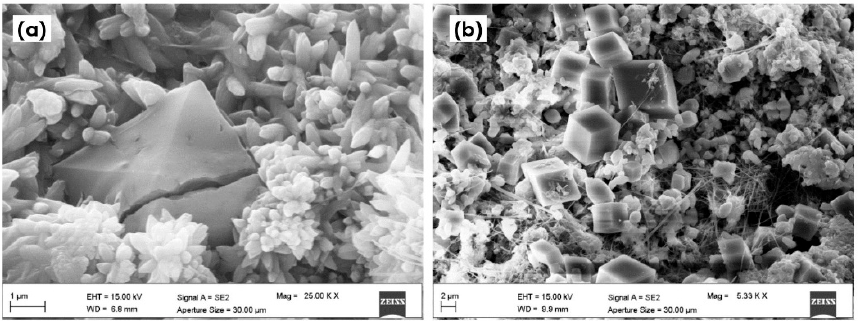
Figure 5. SEM images of soil treated with 7% CaO, compacted at optimum water content after ( a , b ) 2 days of curing, ( c , d ) 7 days of curing, and ( e , f ) 28 days of curing.